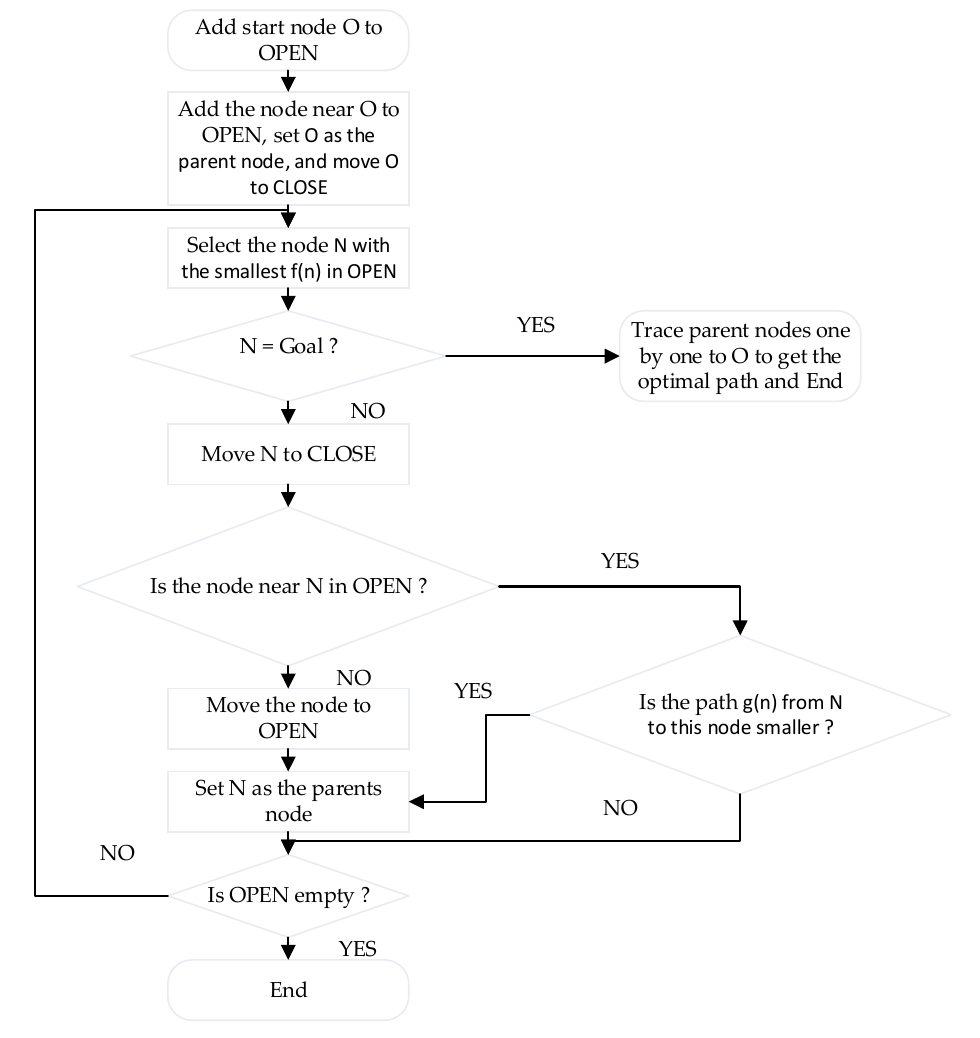
Figure 9. A* Algorithm flowchart.